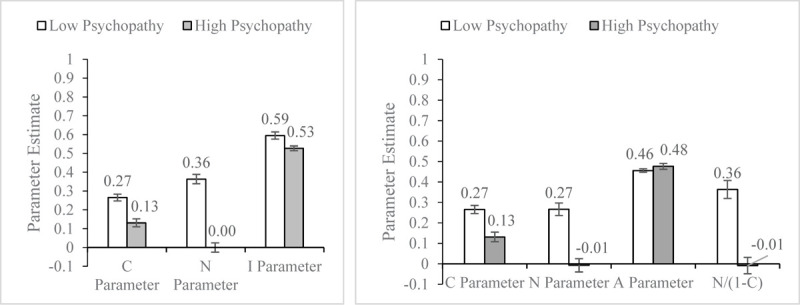
Results of Study 4b by Gawronski et al. (2017) obtained from the CNI model (left) and CAN algorithm (right). Error bars represent ± 1 SE.